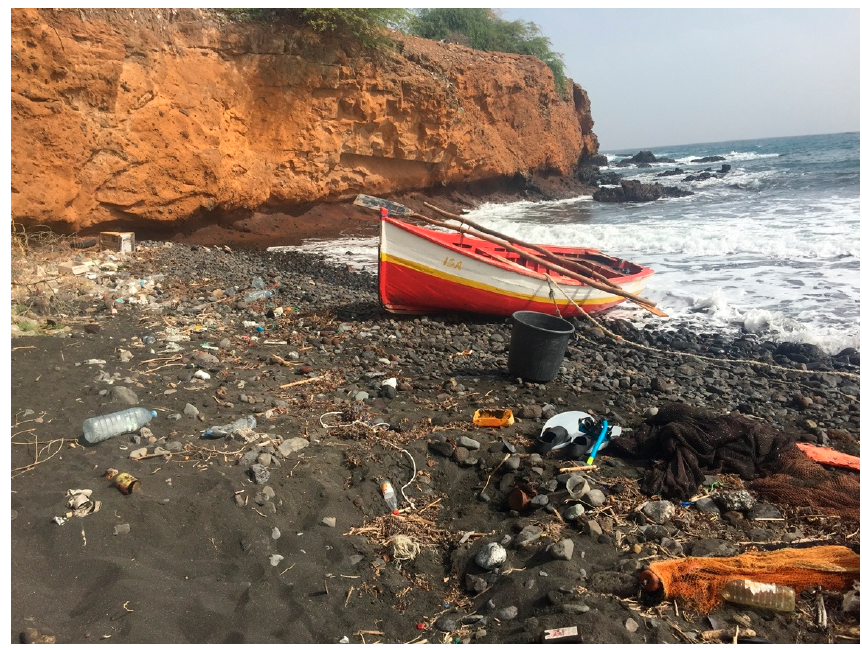
Figure A1. Waste found at the beach (photo by the authors, September 2019).